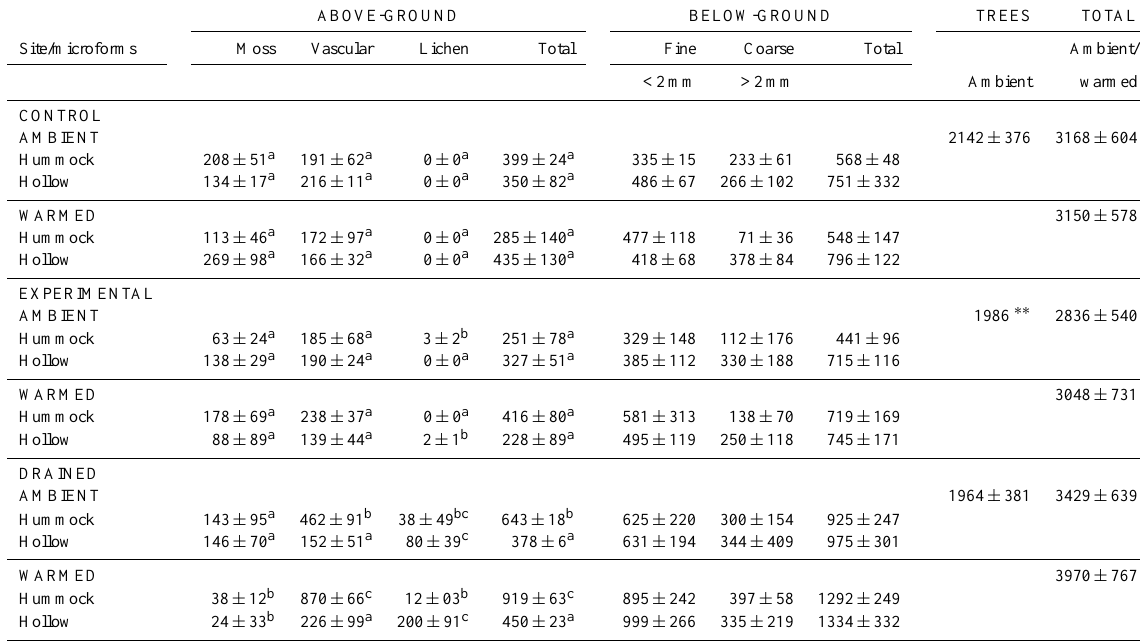
Table 2. Ground-layer and tree biomass (gm − 2 ) at control, experimental and drained sites ∗ . ABOVE-GROUND BELOW-GROUND TREES TOTAL Site/microforms Moss Vascular Lichen Total Fine Coarse Total Ambient/ <2mm >2mm Ambient warmed CONTROL